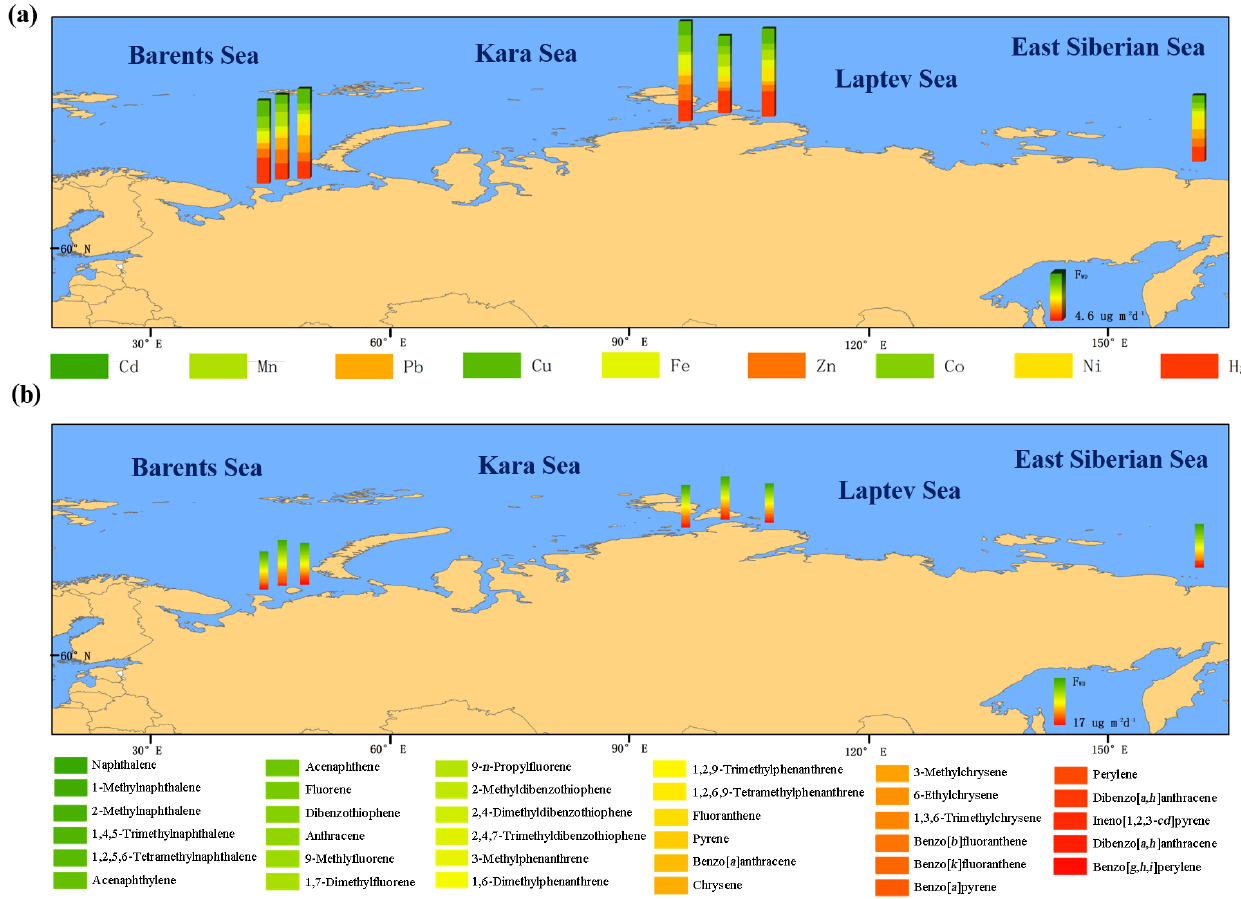
Figure 4. Wet deposition of (a) heavy metals and (b) PAH fluxes. The measured wet deposition of heavy metals and PAHs occurred during the eight snow events encountered during the vessel’s